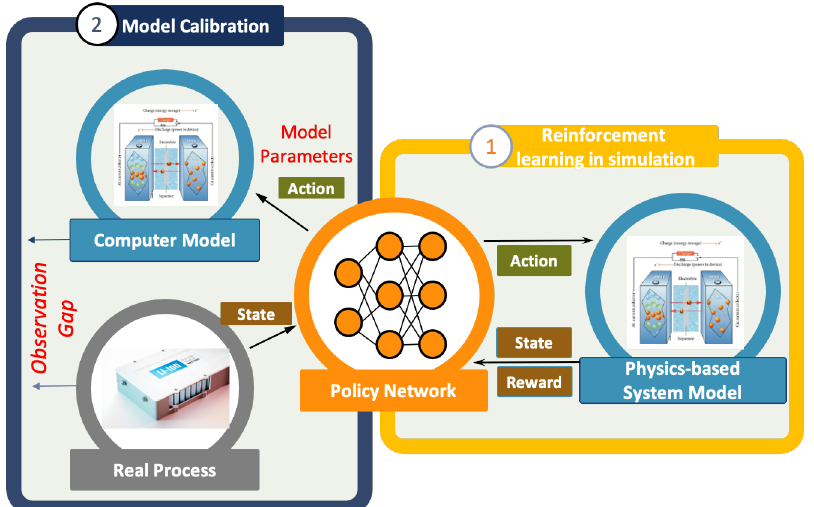
Figure 1. Model calibration: Part (1): the policy network is trained by interacting with the system model. Part (2): the policy network acts as a calibrator at the test